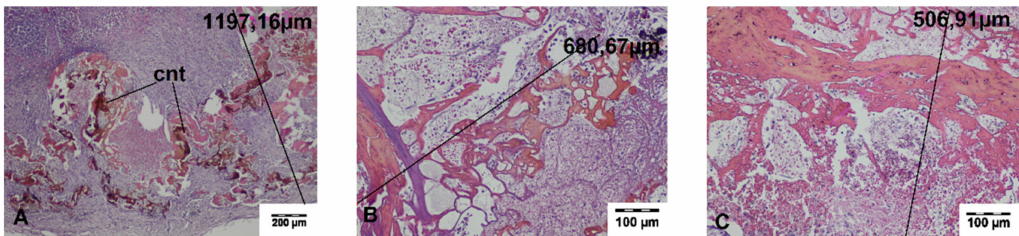
Figure 6. Histopathological sections of the spleen of the pig 7 days after cutting with the diode laser (DL) (HE staining). Black lines indicate the width of the entire zone of thermal damage. ( A ) Residues of the carbonized tissue surrounded by granulation tissue with proliferating fibroblasts and splenocytes in the deeper zone of thermal damage (magnification × 100); ( B , C ) superficial zone of thermally damaged tissue (magnification × 100). cnt, carbonized necrotic